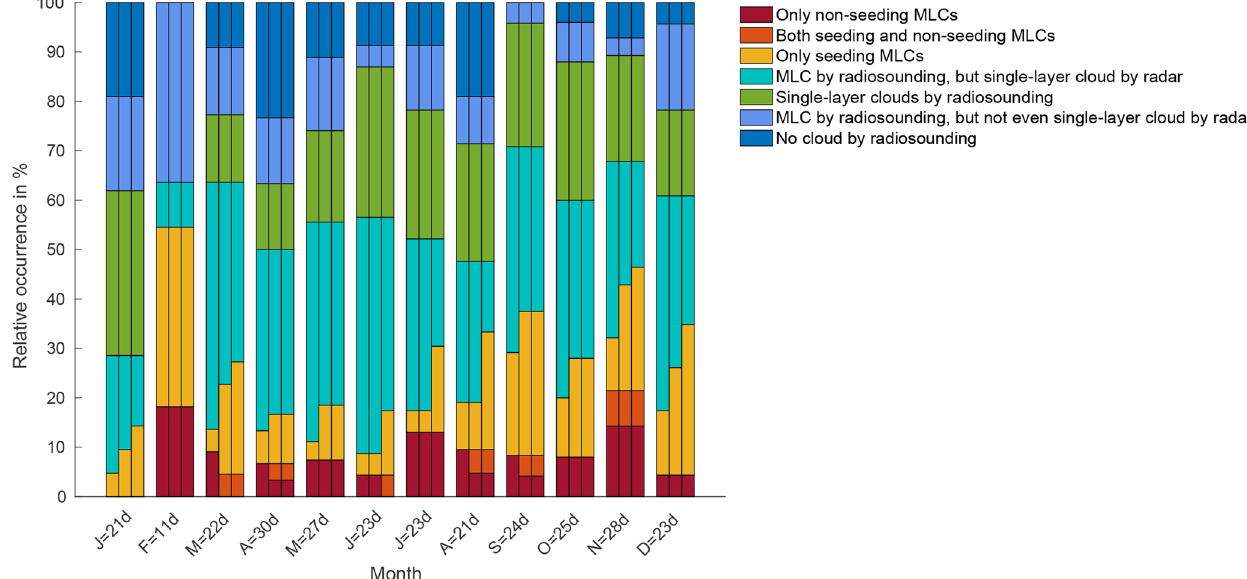
Figure 10. Temporal distribution of MLC days using classification step 2. For each month the left bar refers to the initial ice crystal size r = 100µm, the middle bar refers to the initial ice crystal size r = 200µm and the right bar refers to the initial ice crystal size r = 400µm. On the x axis the given number in the labels refers to the number of days (d) considered for the specific